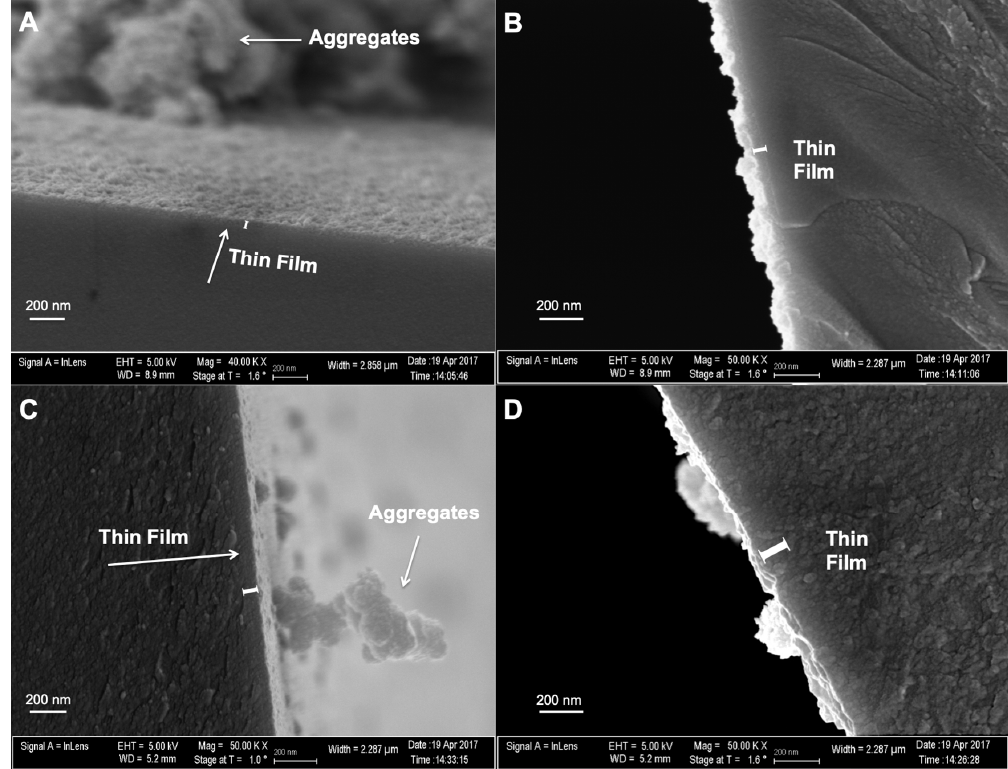
Figure 4. SEM images of capillary tubes loaded with R6G, with a dry time of 1 min and a delay time of ( A , B ) 5 min and ( C , D ) 15 min. Both films were approximately 90 nm thick, although the thickness of the film was highly variable for both delay times.